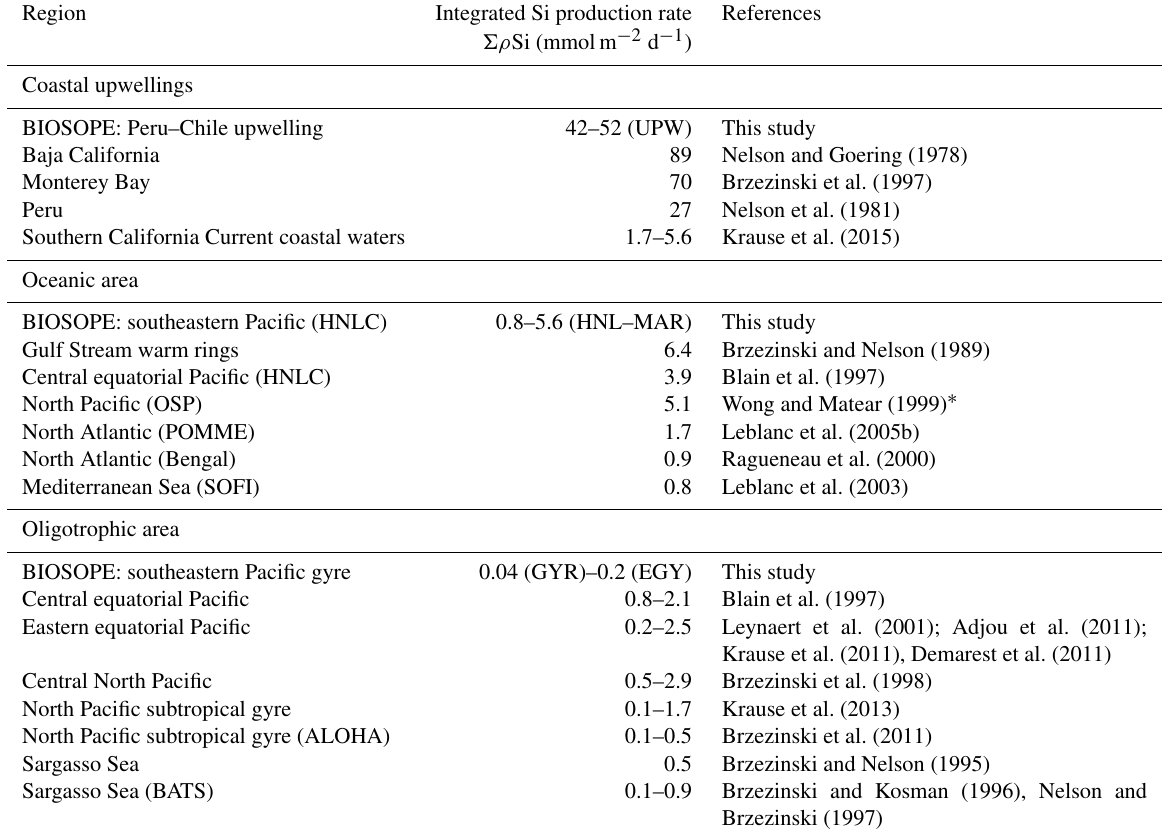
Table 4. Integrated Si production rates in various systems for comparison with our study, from direct 32 Si uptake measurements or from indirect silicate utilization ( (cid:49) SiO 4 ) estimates ( ∗